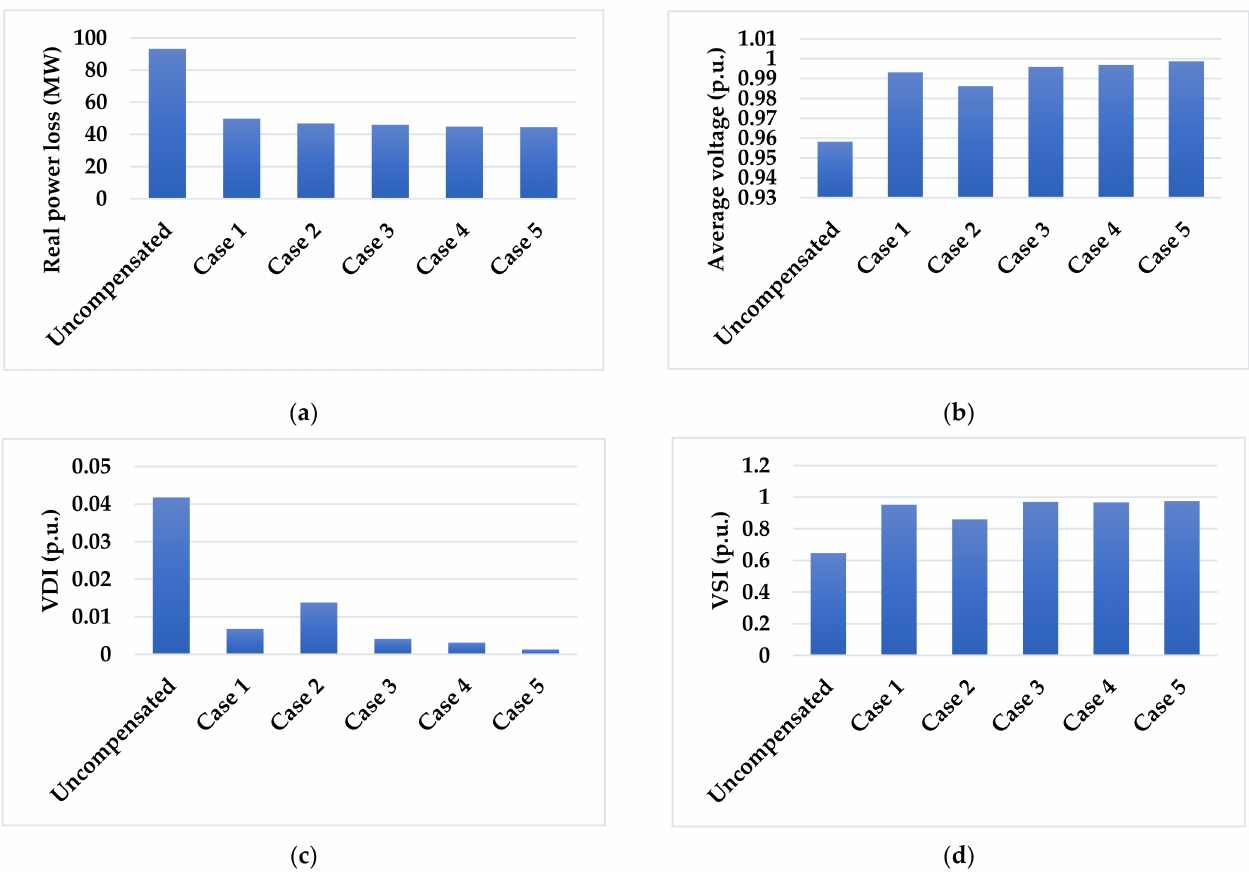
Figure 10. Comparative analysis: ( a ) real power loss; ( b ) average voltage; ( c ) voltage deviation index; and ( d ) voltage stability